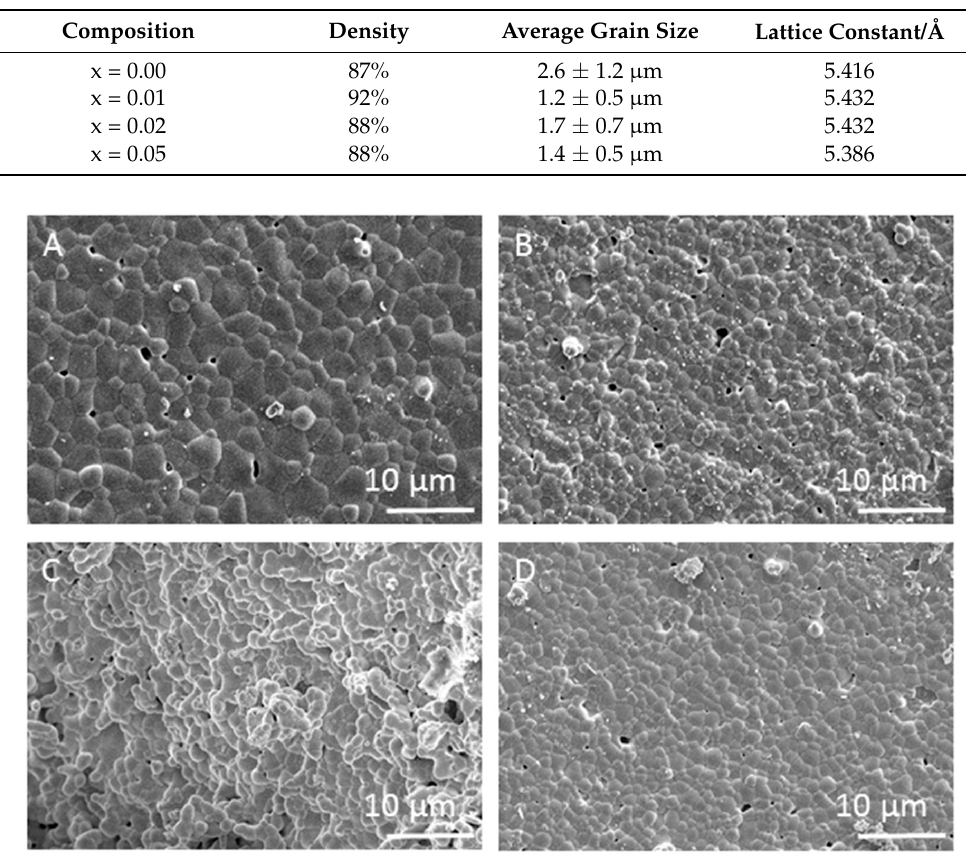
Table 1. Relative densities calculated from Archimedean balance results and the lattice constants, average grain sizes from microscopic evaluation and measured lattice constants from XRD measurements.